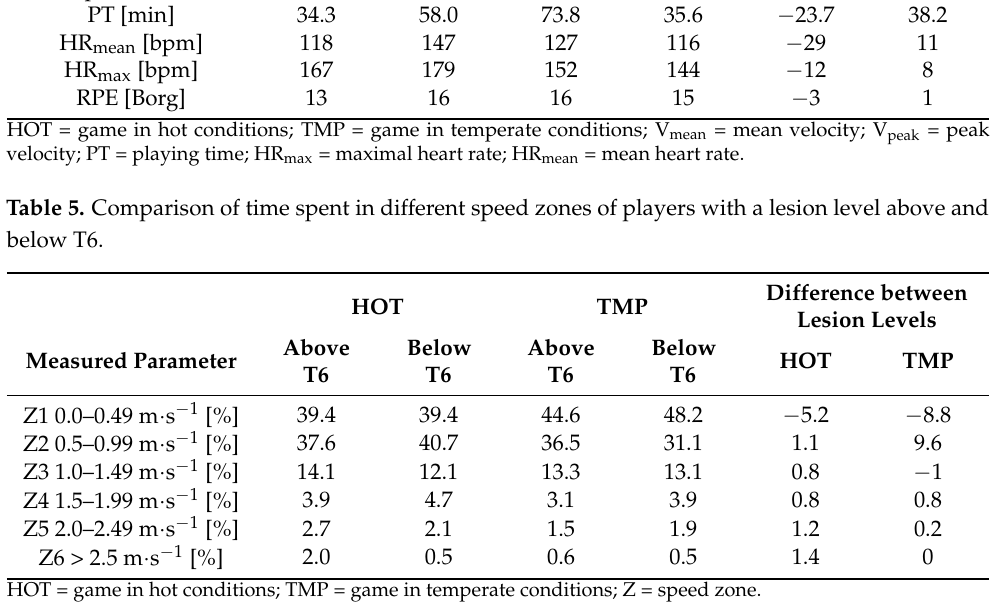
relative sprint